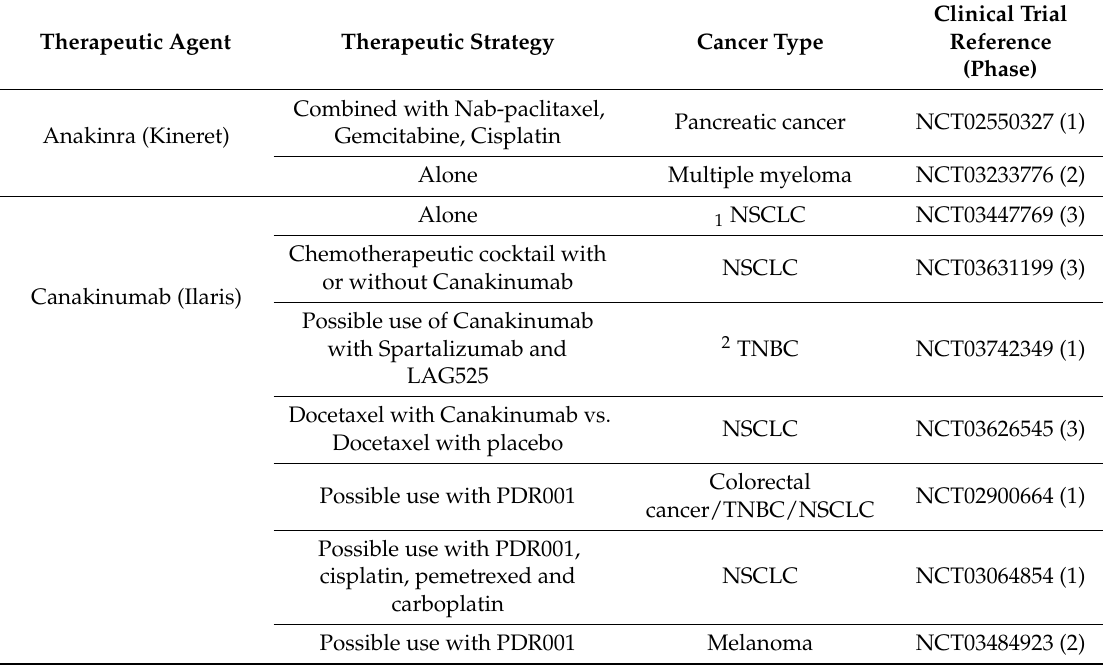
Table 3. Therapeutic agents targeting interleukin-1 or interleukin-1 receptor in interventional clinical trials currently recruiting or not yet recruiting. Data acquired from the U.S. National library of medicine (http://clinicaltrials.gov, accessed on 16 January